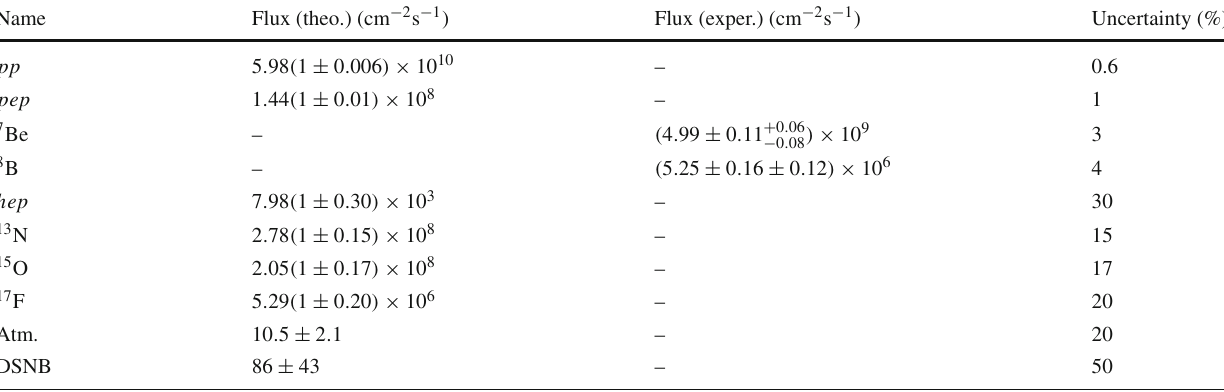
Table 4 Recommended normalization values of all relevant neutrino fluxes for direct dark matter searches. This is a subset of the values shown in Table